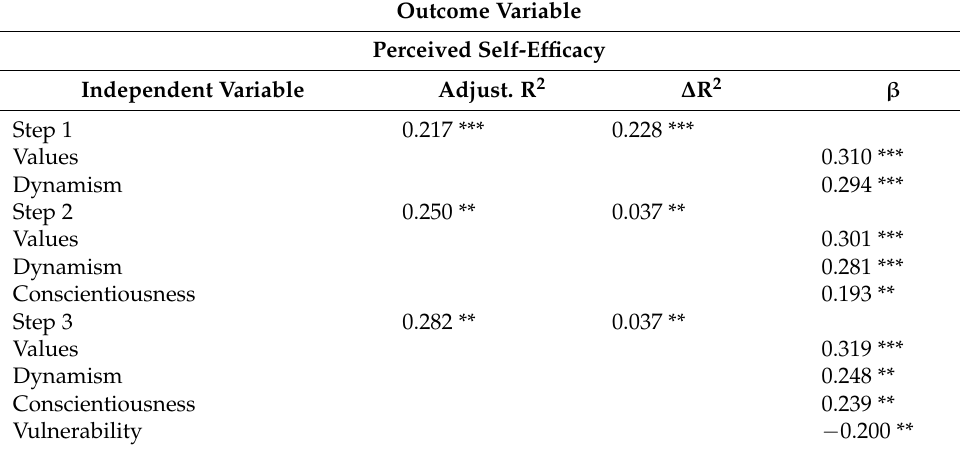
Table 8. Results of Hierarchical Linear Regression Analyses of Clown Therapists working in